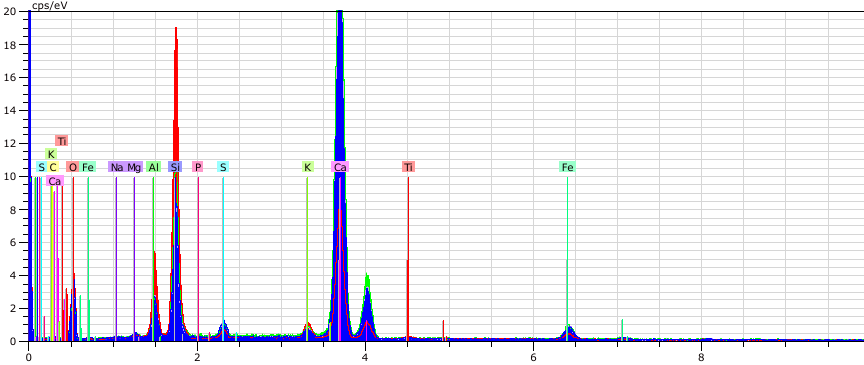
Figure 7. Chemical composition spectra.